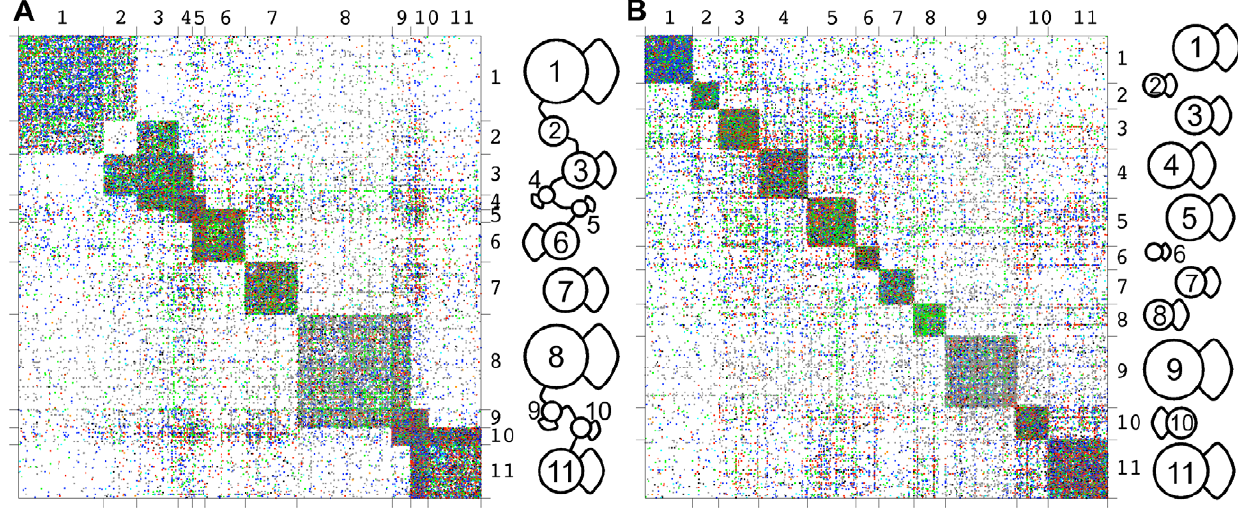
Figure 5. Comparison of block assignment. For 11 classes, we show the adjacency matrix of the HPRD protein interaction network with rows and column ordered to show non-diagonal (A) and diagonal (B) block structure plus the corresponding image graphs for diagonal block models and non-diagonal block models. Note how the non-diagonal models allow to capture overlap between cohesive blocks but also to detect groups of nodes which are non-cohesive but have similar connection patterns to other classes of proteins. The color of the links codes the experiment type: Y2H : grey, in-vitro : blue, in-vitro + Y2H : turquoise, in-vivo : green, in-vivo + Y2H :orange, in-vivo + in-vitro : red, in-vivo + in-vitro + Y2H :black. The dots representing the matrix entries have been enlarged for better visibility.